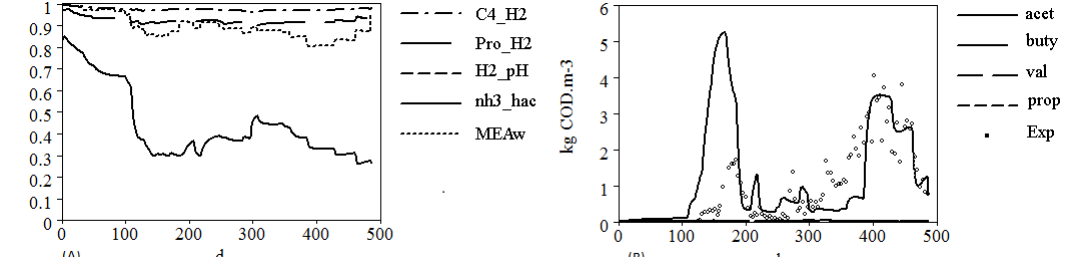
Figure 5: Simulated inhibition effects (A) from H2 on butyrate and propionate degradation (C4 H2 and Pro H2), pH effects on hydrogen degradation (H2 pH) and NH 3 and MEAw effects on acetate degradation (nh3 hac and MEAw) in AD of MEAw. VFA accumulation (B), acet, acetate; buty, butyrate; val, valerate; prop, propionate